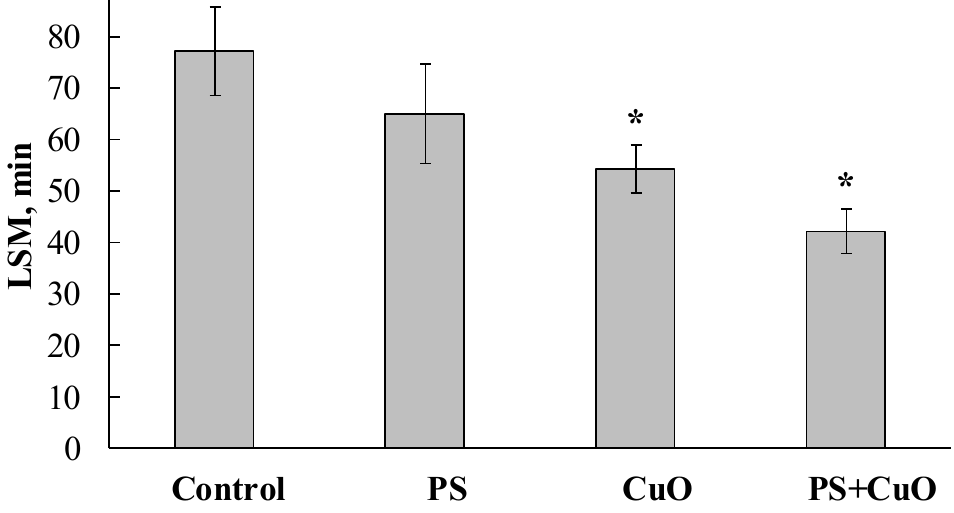
Figure 1. Changes in M. trossulus LMS when exposed to µ PSs and CuO-NPs (mean ± standard deviation, n = 30); *—difference from control was significant at p ≤